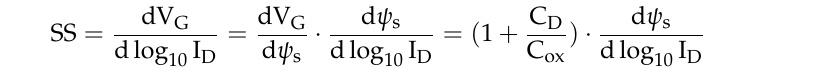
cm Figure 8. I d -negative gate voltage with different Interface Density. It can be seen that when the absolute value of negative voltage is very low ( − 1.2 V ~ 0 V), the conduction current of the device decreases with the increase of irradiation dose; when the absolute value of negative voltage is large (> 1.2 V), and the irradiation dose has little effect on the conduction current of the device. The tangent diagram of the energy band of the device under different negative gate voltages is shown in Figure 9 (transverse tangent of 2 nm upward at the interface between box layer and silicon film). It can be seen that the higher the irradiation dose, the lower the energy band in the channel region of the device. The more negative the gate voltage, the higher the energy band in the channel region, which indicates that the polarity of the electric field generated by the gate voltage in the channel region of the device is opposite to that caused by the total dose of irradiation. When the negative bias voltage is greater than − 1.2 V, the electric field generated by the gate voltage is equivalent to the additional